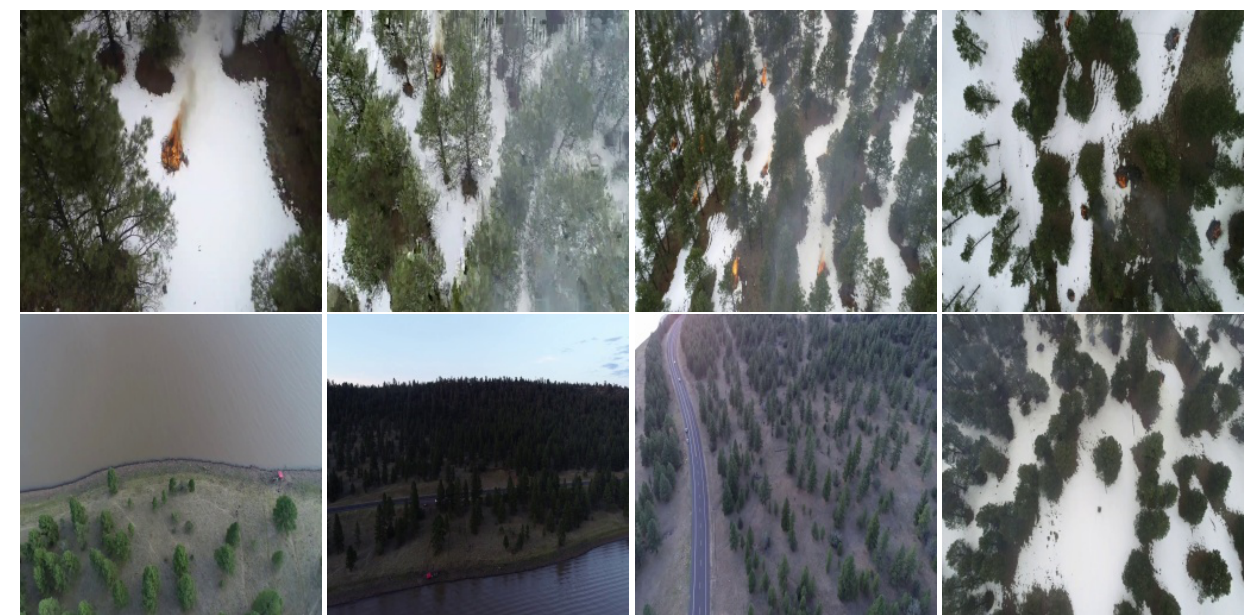
Figure 5. Examples from the FLAME dataset. Top line: Fire images and bottom line: Non-Fire images.